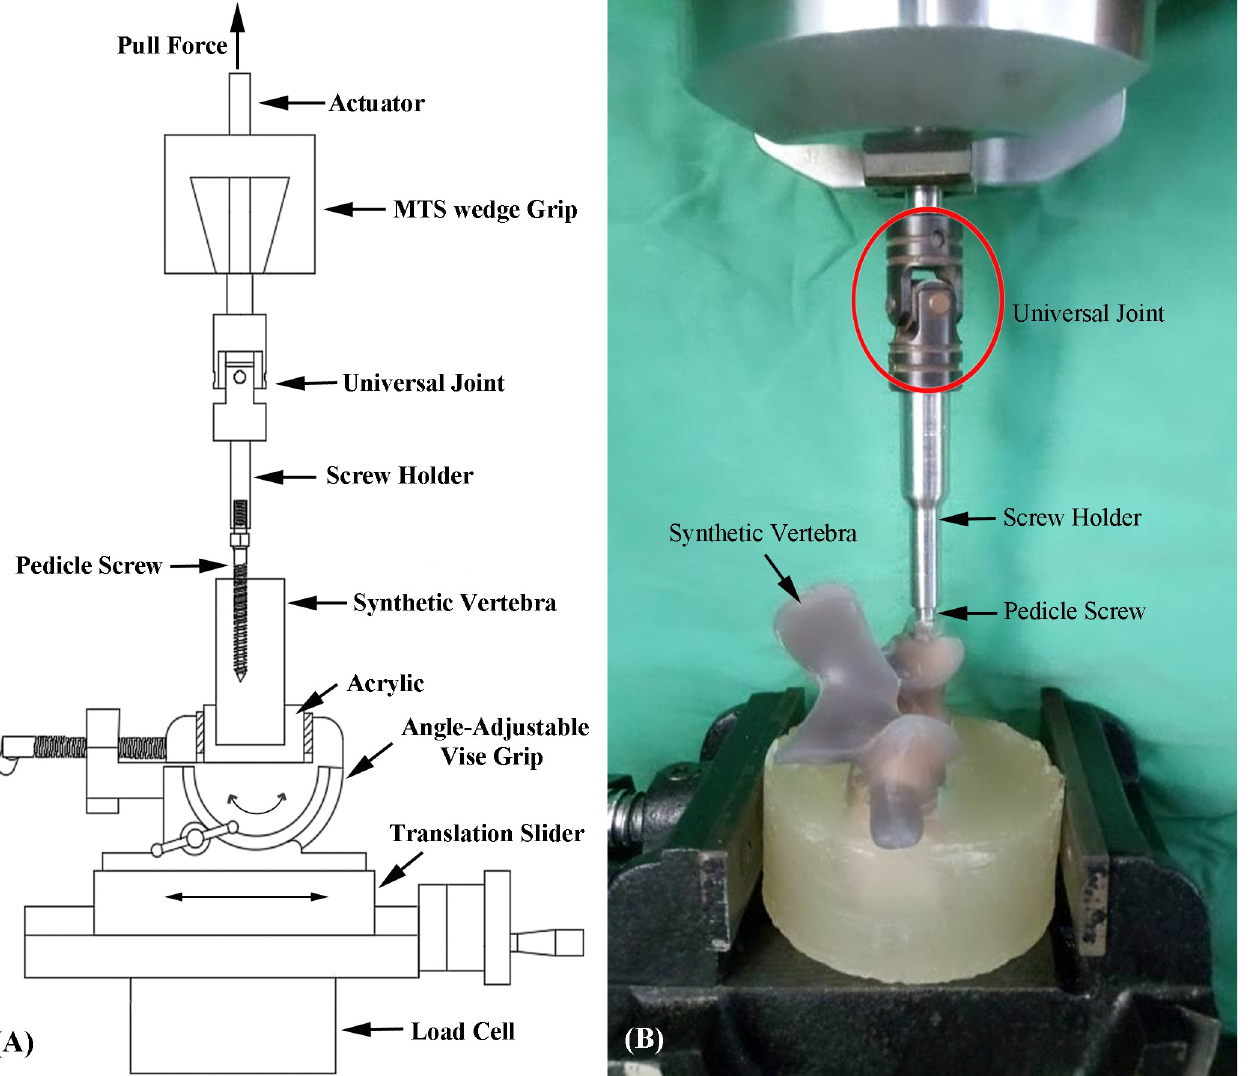
Fig 2. (A) Schematic drawing and (B) photograph showing the screw pullout test in a standard L4 vertebral specimen. Each prepared specimen was secured to a custom-made grip mounted on the platform of the testing machine. The pedicle screw was secured to a cylindrical adapter with universal joint, and the cylindrical adapter was fixed to the upper wedge grip of the testing